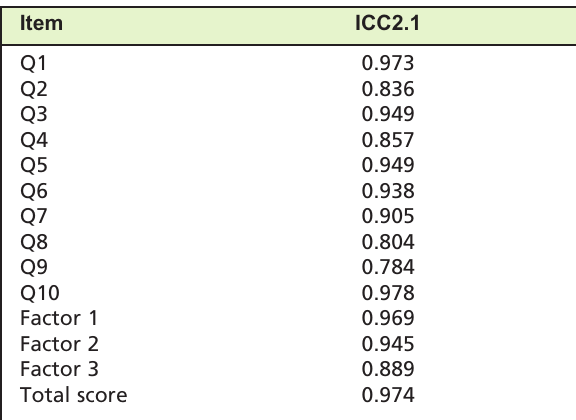
Intraclass coefficient correlation (ICC2.1) of the Table VI: Malay version of the Identification of Functional